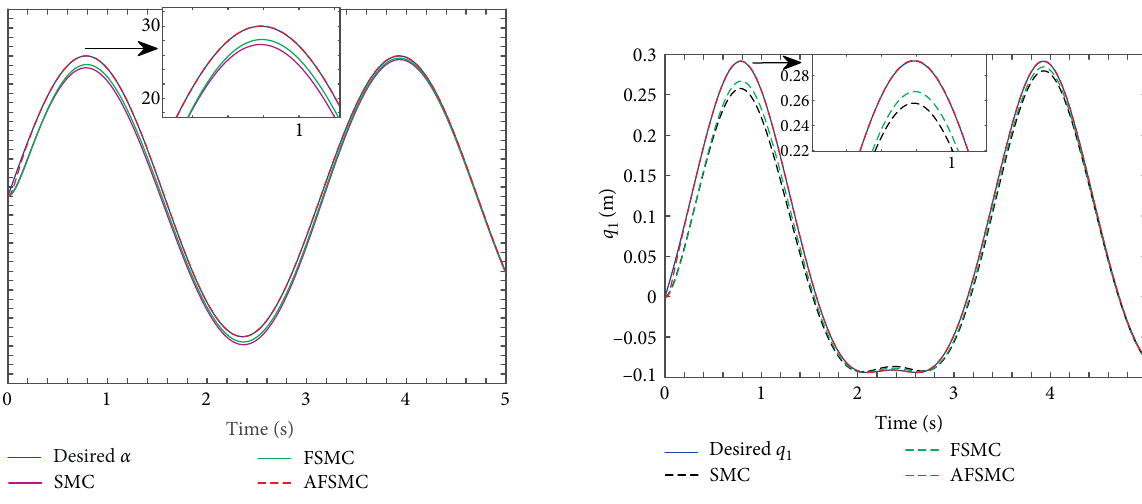
Figure 11: Trajectory tracking about rotation angle controllers.